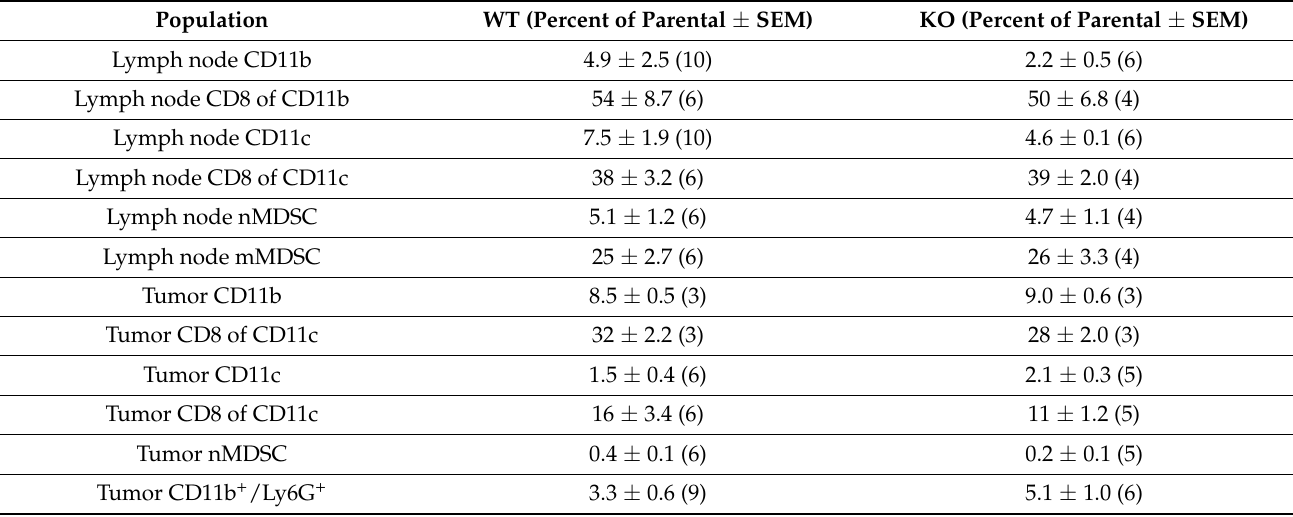
Table 1. Additional immune cell populations determined by flow